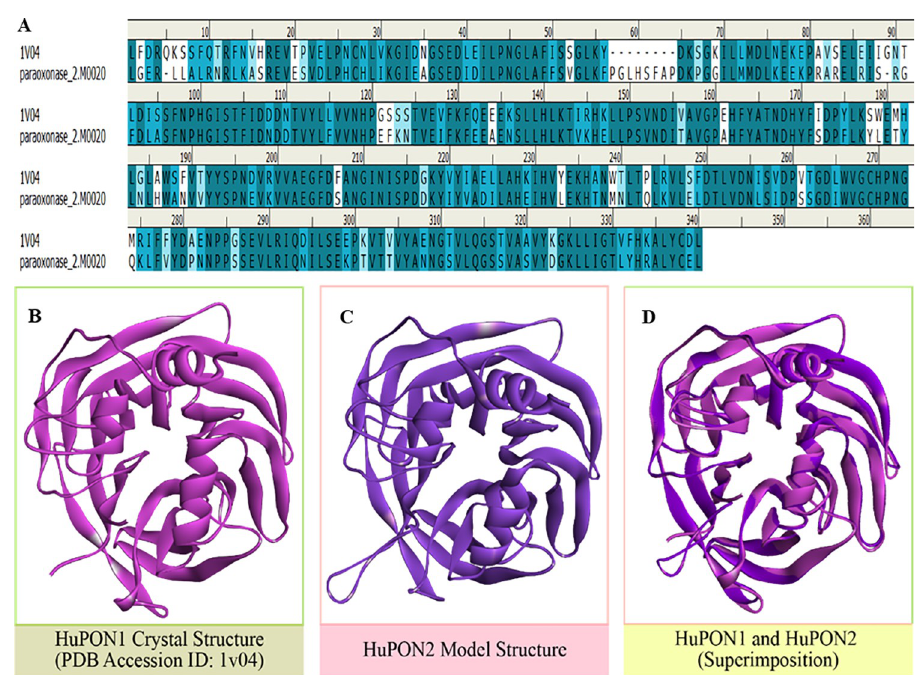
Fig 2. In silico analysis of HuPON2. A. Sequence alignment of HuPON2 on Chi-PON1 (PDB:1V04) shows 64.7% sequence identity and 82.6% sequence similarity. B. Crystal structure of HuPON1 (PDB:1V04); magenta color-coded. C. Homology model of HuPON2, prepared from HuPON1 template (PDB:1V04); violet color-coded. D. Superimposition of HuPON1 (magenta) and HuPON2 (violet), shows the close similarity of both the structures, RMSD value of 0.543. The analysis was performed in Discovery Studio